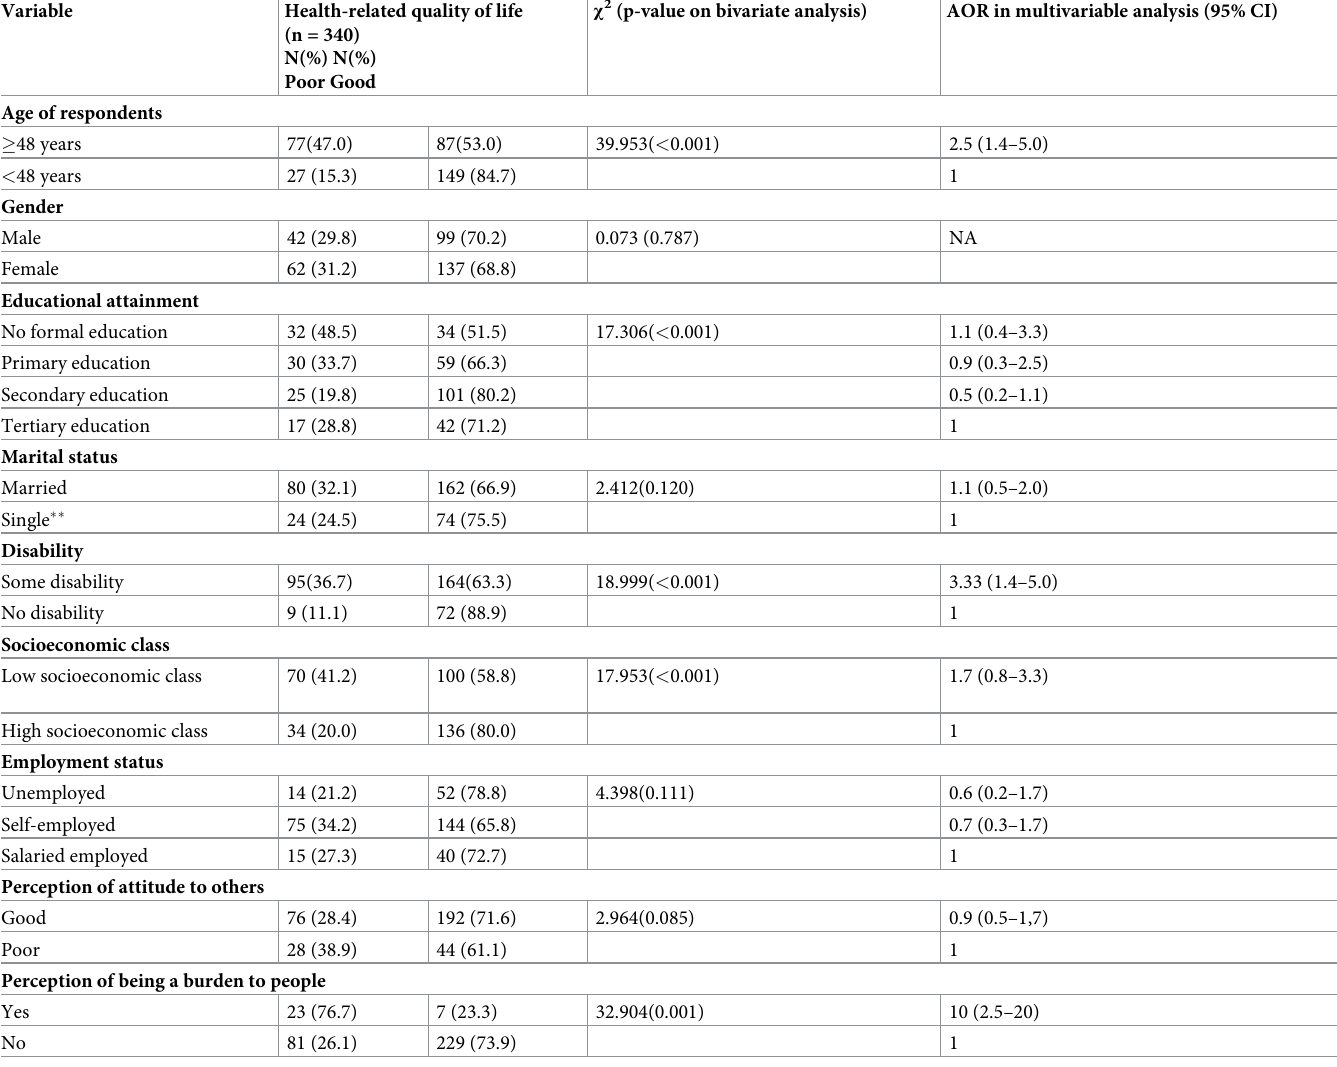
Table 5. Bivariate and multivariate analyses on factors affecting the poor quality of life in the respondents with onchocerciasis.